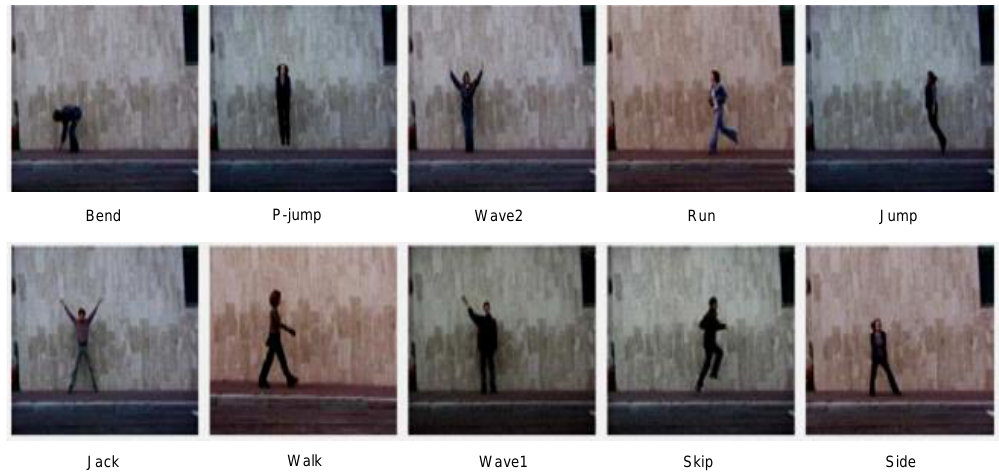
Figure 7. Sample actions from the benchmark Weizmann